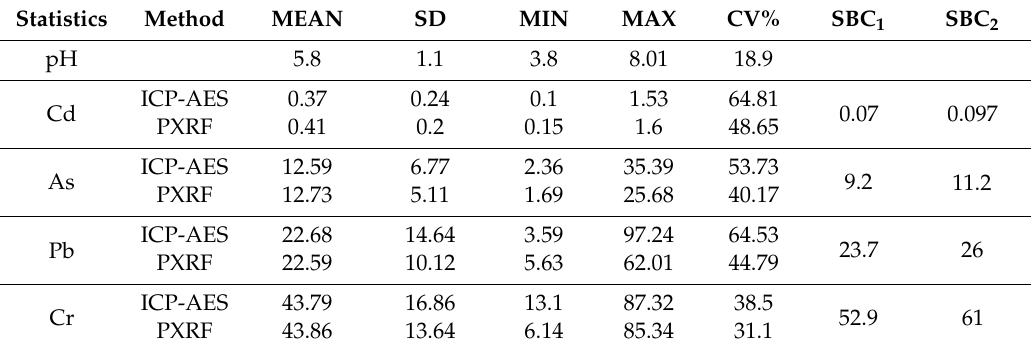
Table 1. Descriptive statistics of soil heavy metal concentrations measured by ICP-AES and PXRF (mg kg − 1